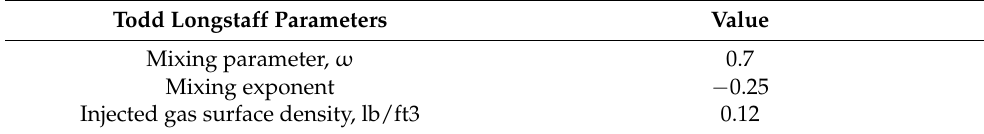
Table 3. Pseudo-miscible injection parameters used for the CO 2 injection cases.